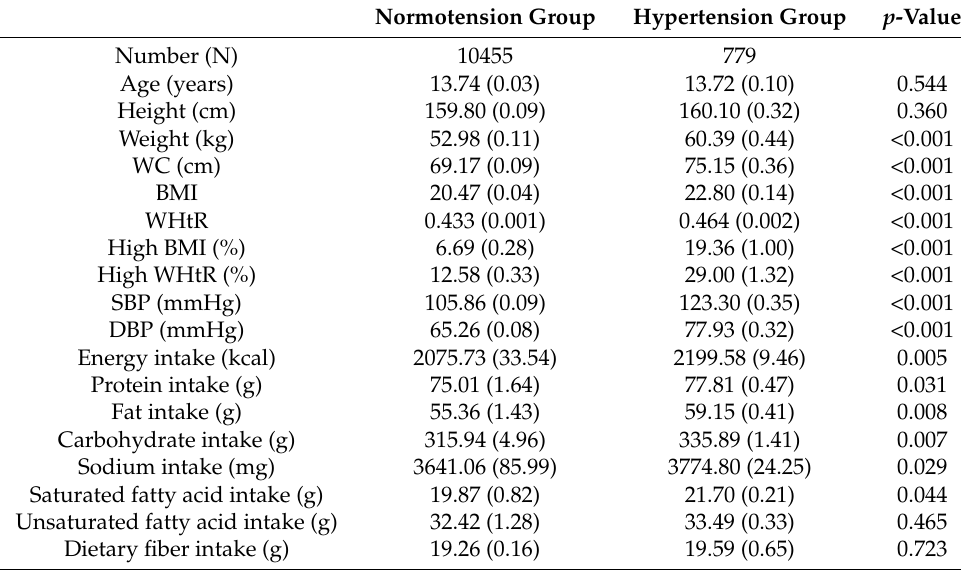
Table 5. Differences between normotensive and hypertensive groups. Data expressed as mean (standard